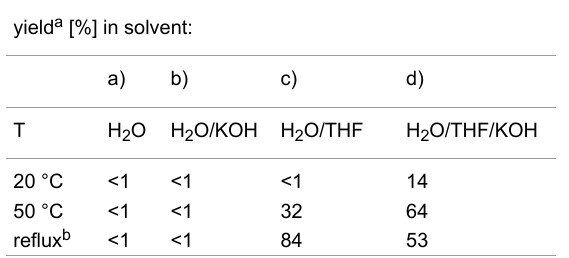
Table 1: Hydrolysis of BIFOXSiCl 2 ( 7 ) to BIFOXSi(OH) 2 ( 9 ) (Scheme 3) in different solvent mixtures, with or without KOH at differ- ent temperatures.